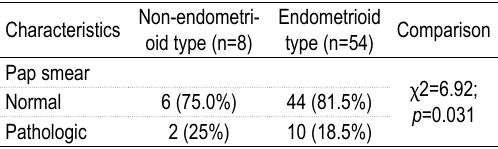
Table 2. relationship between Pap smear testing and non-endometri- characteristics oid type (n=8)